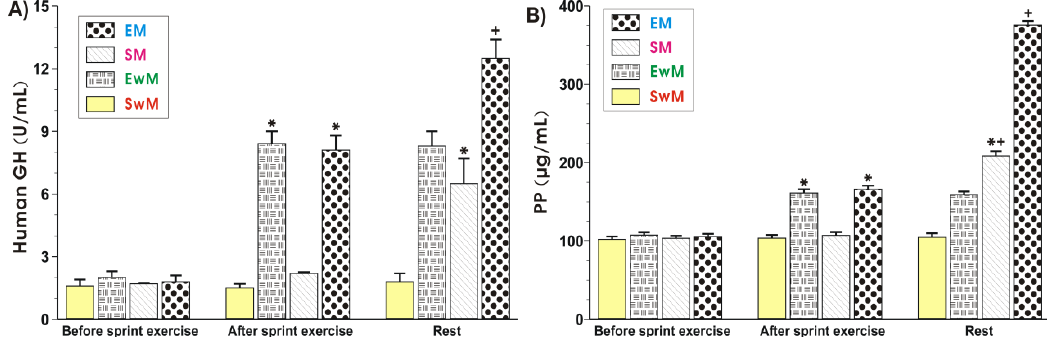
Figure 4. The alterations in plasma human growth hormone (hGH) (A ) and pancreatic polypeptide (PP) (B ) levels determined at basal conditions and after the end of exercise in subjects with or without meal consumption. Values represent means ± SD for 26 subjects. Statistical analysis was done by two-way repeated measures ANOVA and Tukey post hoc test. An asterisk indicates a significant increase ( p < 0.05) as compared with initial values at the beginning of the test. Asterisk and cross indicate a significant increase ( p < 0.05) as compared with respective values in group SM before meal ingestion. Cross indicates a significant increase ( p < 0.05) as compared with respective values in group EM before meal consumption. EM—the 30 s Wingate Test (W-T30) with ad libitum test meal intake, EwM—W-T30 without ad libitum test meal intake, SM—sedentary with ad libitum test meal intake, SwM—sedentary without ad libitum test meal